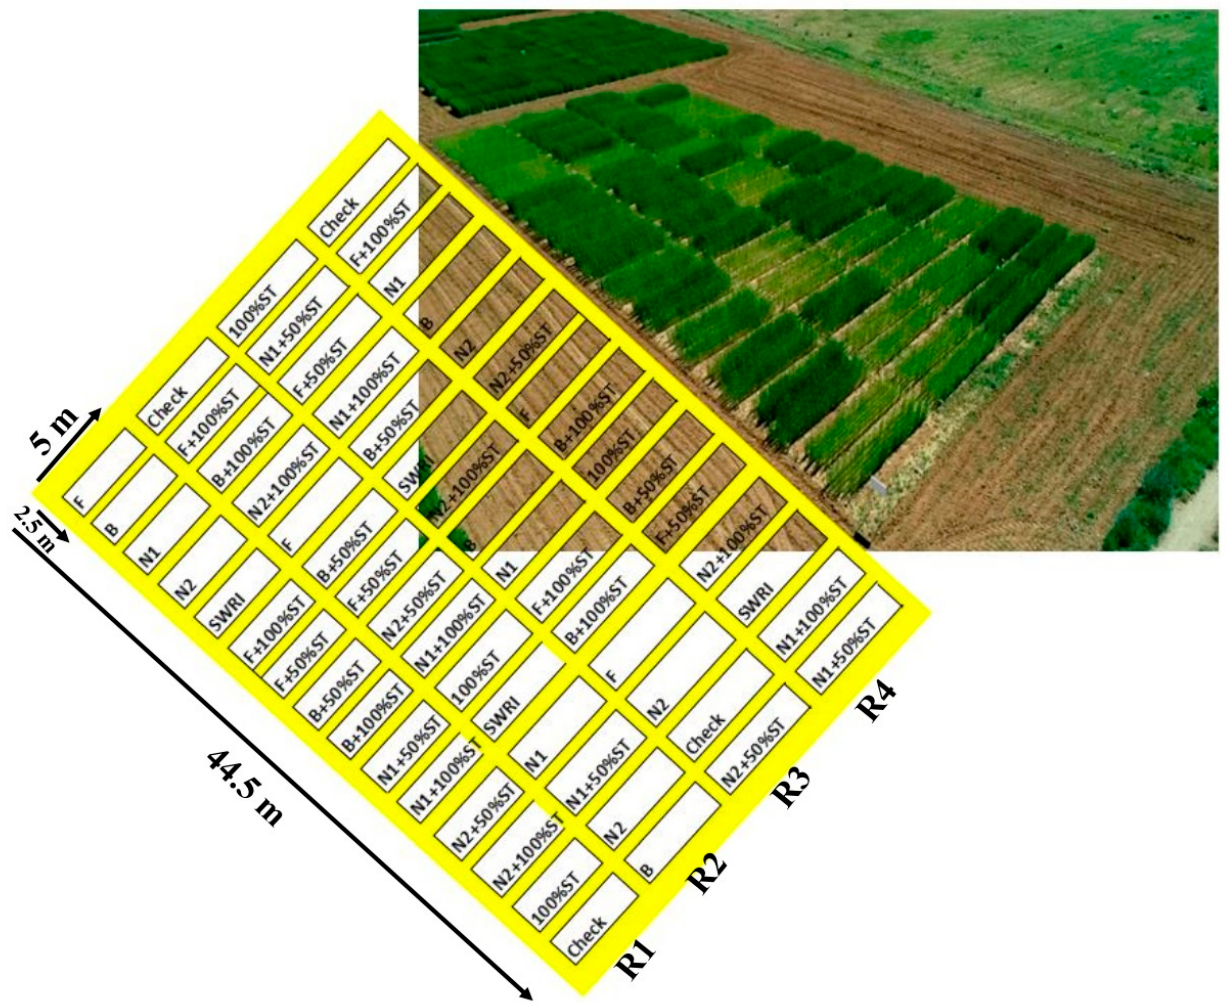
Figure 1. Schematic presentation of an applied randomized complete block design to assess the effects of PGPR biofertilizers and their combinations with 50% and 100% of soil test (ST) need-based N, P, and Zn chemical fertilizers on the quantitative and qualitative characteristics of the Azar-2 rainfed wheat cultivar during the 2018–2019 growing season. F (Fla-wheat), B (Barvar-2), N1 (Nitroxin), N2 (Nitrokara), SWRI (Soil and Water Research Institute growth stimulant), ST (soil test chemical fertilizers).